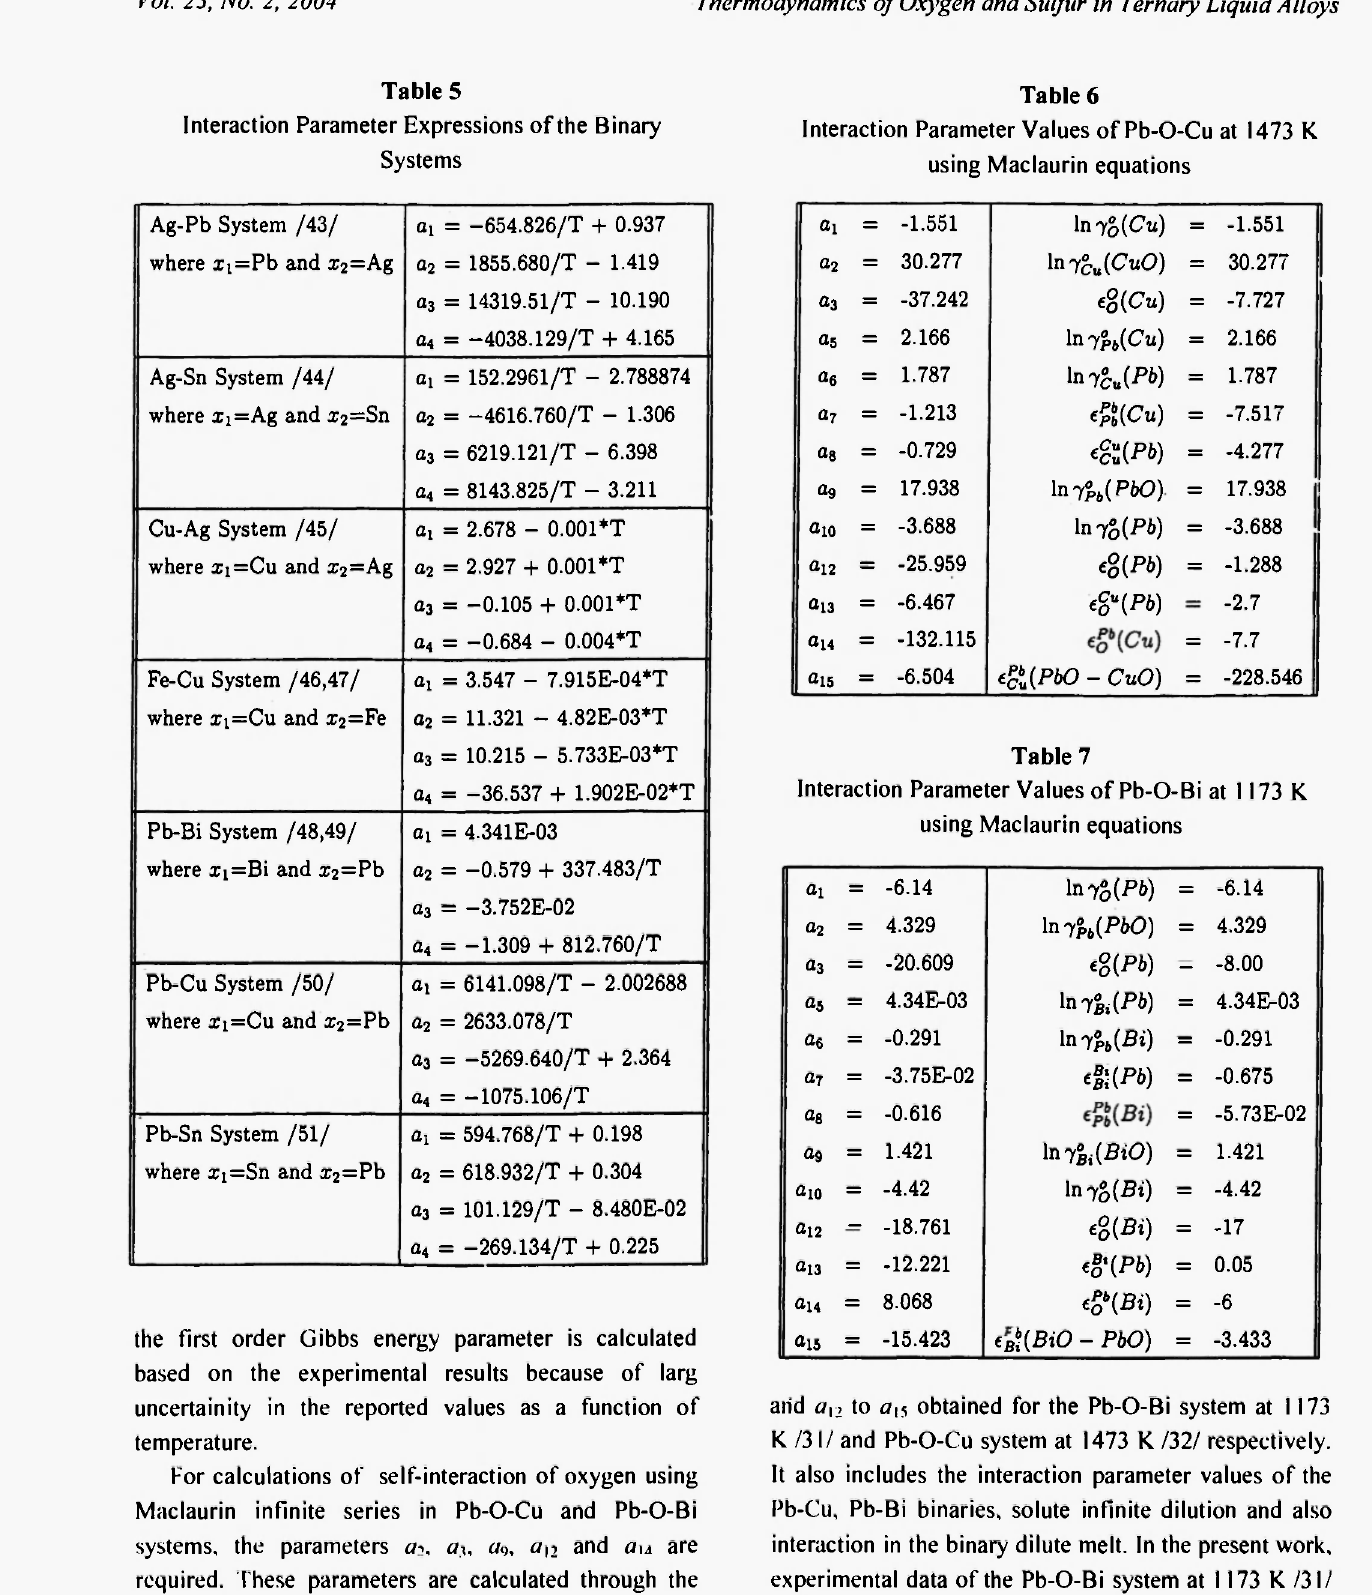
Interaction Parameter Values of Pb-O-Bi at 1173